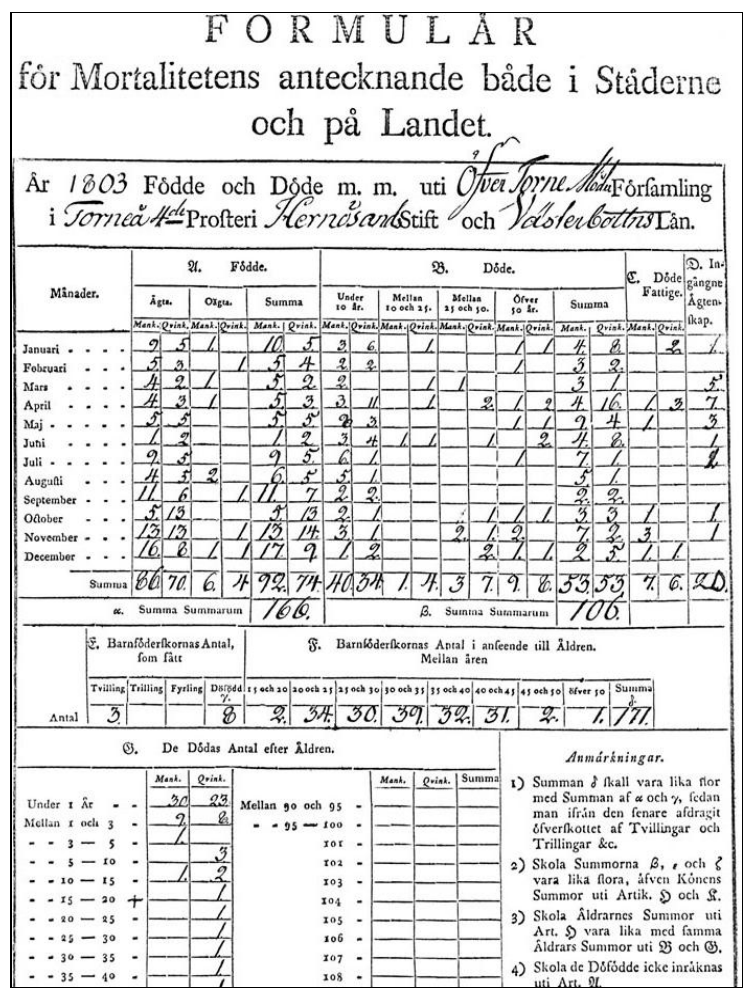
Figure 1. Reporting annual deaths in the Parish—Example of a Tabellverket